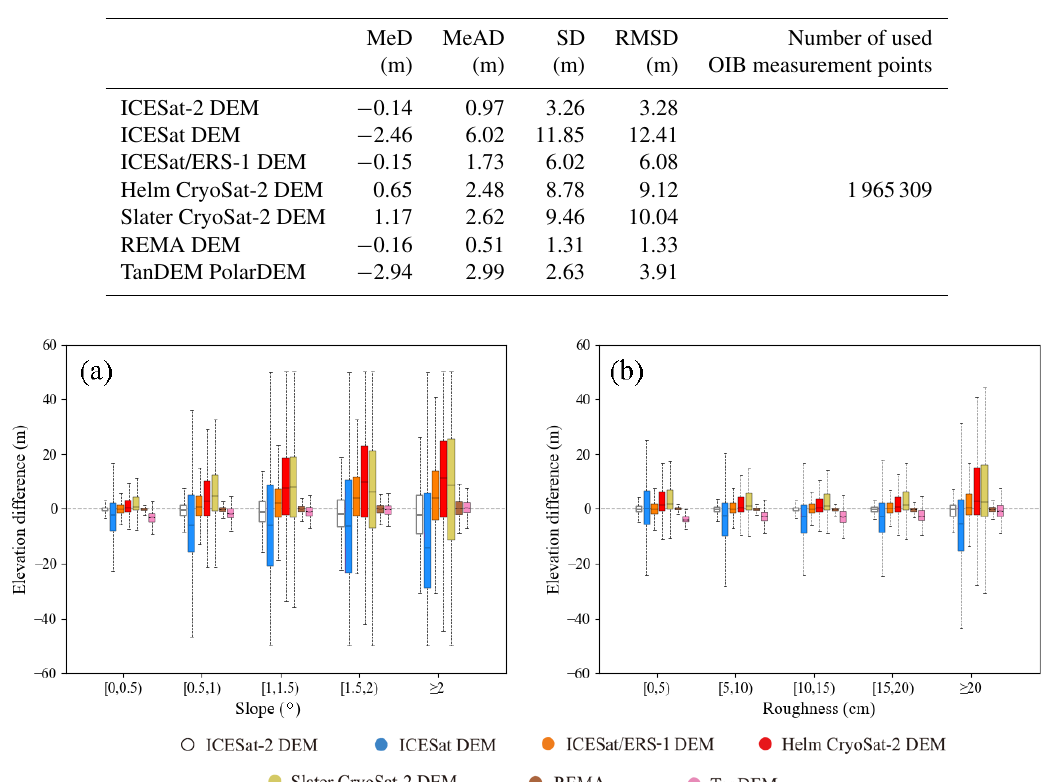
Table 6. Comparisons between the ICESat-2 DEM, ICESat DEM, ICESat/ERS-1 DEM, Helm CryoSat-2 DEM, Slater CryoSat-2 DEM, REMA DEM, TanDEM PolarDEM and OIB airborne elevation measurements in areas of low elevation change from 2009 to 2019.